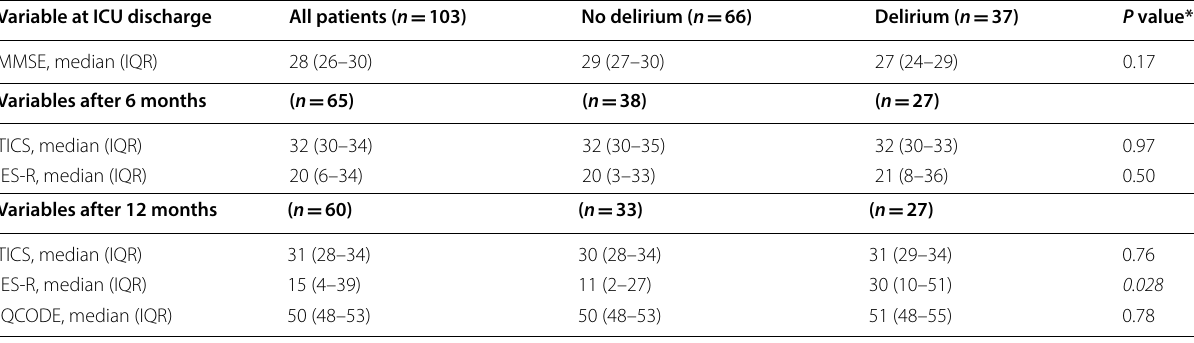
Table 2 Cognitive and psychosocial outcomes of all patients, and of patients with and without delirium during ICU stay